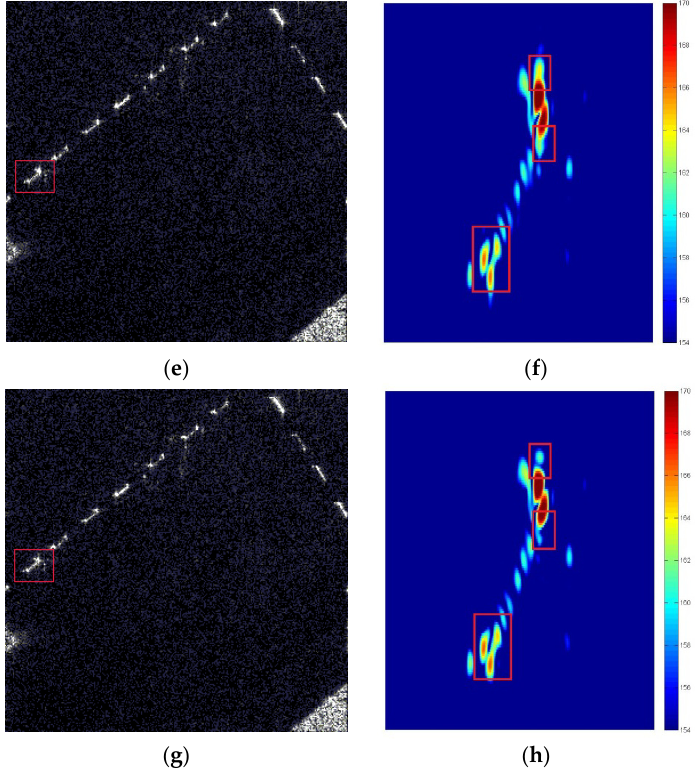
Figure 15. Comparison of imaging results: ( a ) the real SAR image; ( b ) enlarged view of selectable portion in ( a ); ( c ) stop-go model image; ( d ) enlarged view of selectable portion in ( c ); ( e ) the continuous rectilinear model image; ( f ) enlarged view of selectable portion in ( e ); ( g ) continuous tangent model image; ( h ) enlarged view of selectable portion in ( g ).